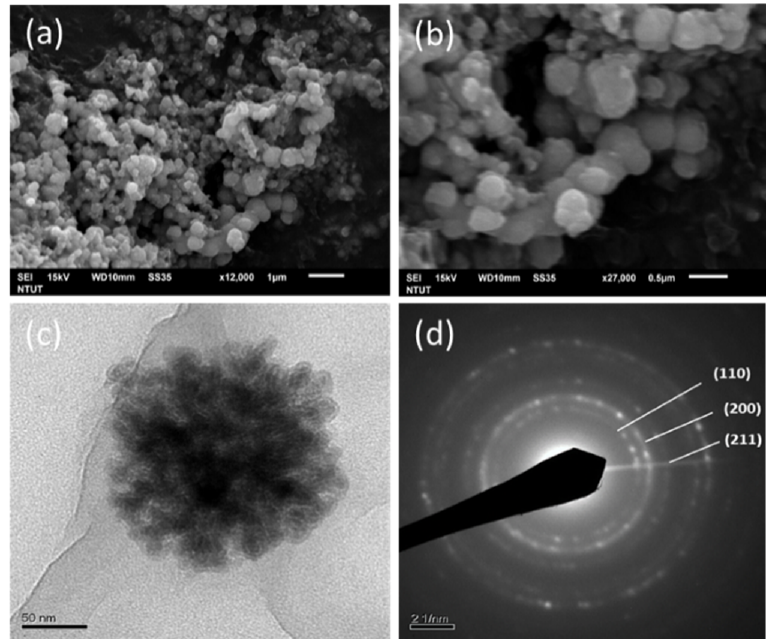
Figure 2. Scanning electron microscopy (SEM) of mesoporous iron particles at magnifications of 1200× ( a ) and 2700× ( b ), TEM appearance at 6000× ( c ), and diffraction pattern ( d ).